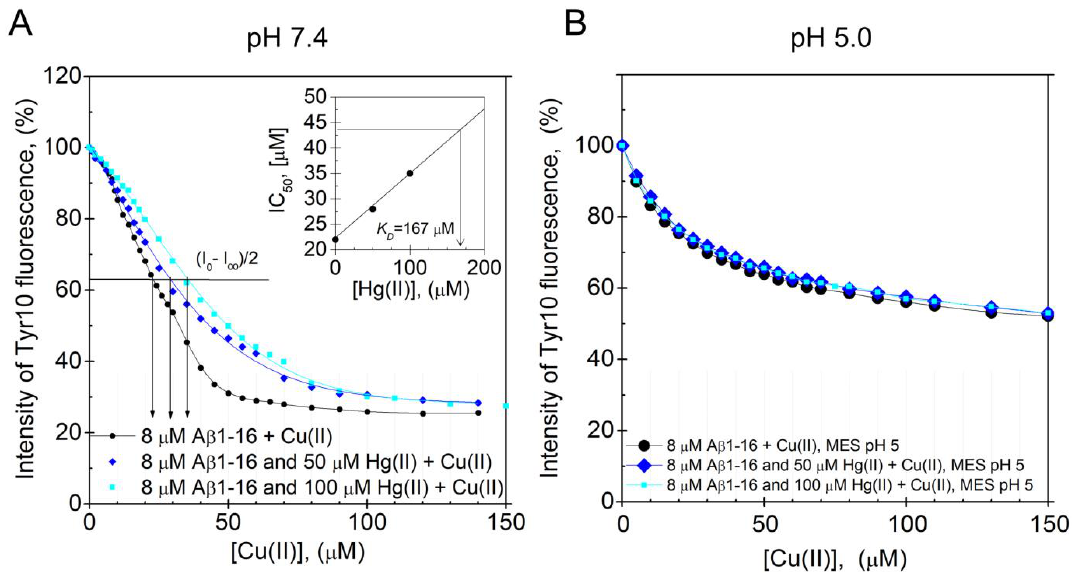
Figure 5. Dissociation constants for the A β · Hg(II) ion complex determined from intrinsic fluorescence quenching. Competitive binding using Tyr10 intrinsic fluorescence quenching experiments were performed by titrating Cu(II) ions onto 8 µ M monomeric A β 16 peptides in 100 mM NaCl + 20 mM HEPES bu ff er, pH 7.4 ( A ) or 20 mM MES bu ff er, pH 5.0 ( B ) at + 25 ◦ C in the absence and presence of